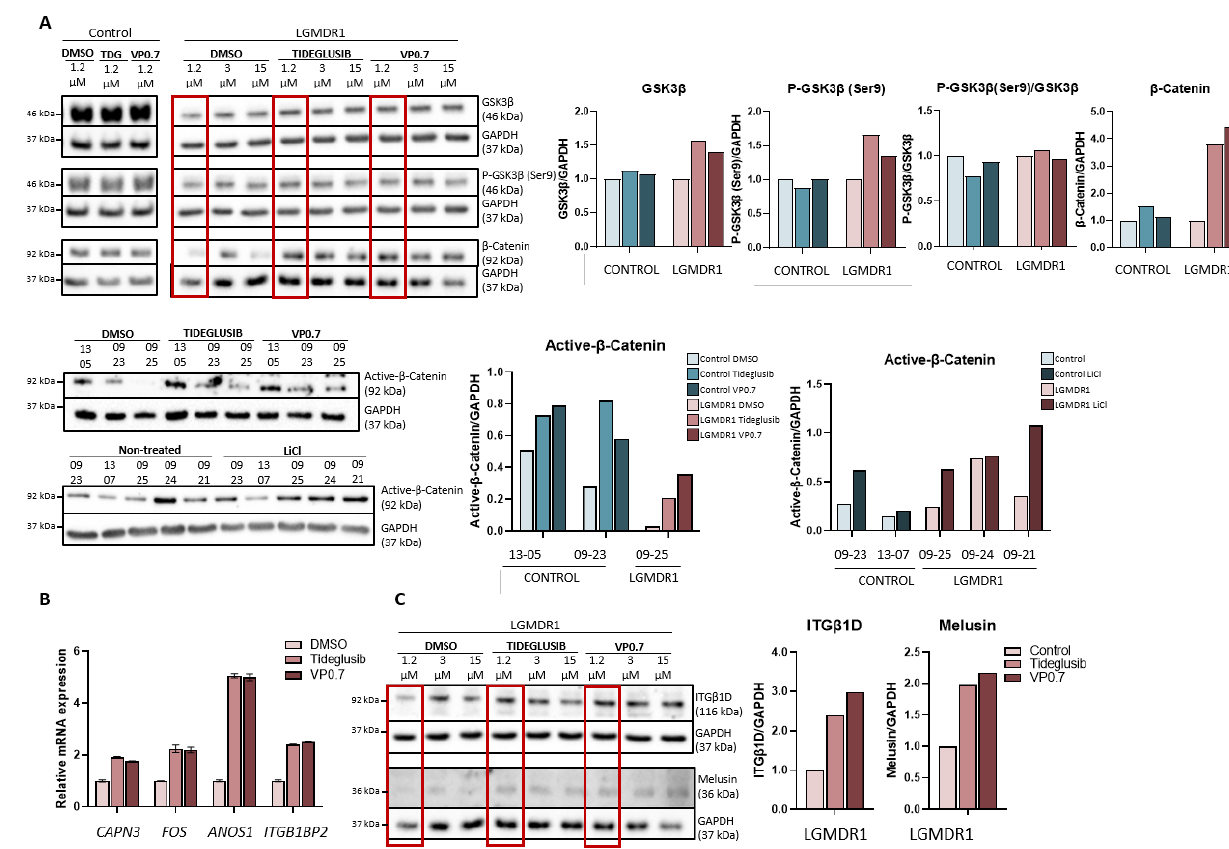
Figure 4. Activation of the Wnt pathway in human myotubes on day 8 of differentiation and after 48 h of treatment with Tideglusib and VP0.7 at three concentrations (1.2, 3.0 and 15.0 µM) and LiCl in control ( n = 1) and patient LGMDR1 ( n = 1). ( A ) Wnt signaling pathway activation: western blot of total GSK-3 β , P-GSK-3 β (Ser9), P-GSK-3 β /GSK-3 β , total β -catenin and active β -catenin. ( B ) Expression of CAPN3 , FOS , ANOS1 and ITGB1BP2 genes in LGMDR1 myotubes ( n = 1 with technical triplicates). ( C ) Western blot of structural proteins: ITGβ1D and melusin. In red, lowest concentration used in the LGMDR1 myotubes (1.2 µM) for densitometry analysis.